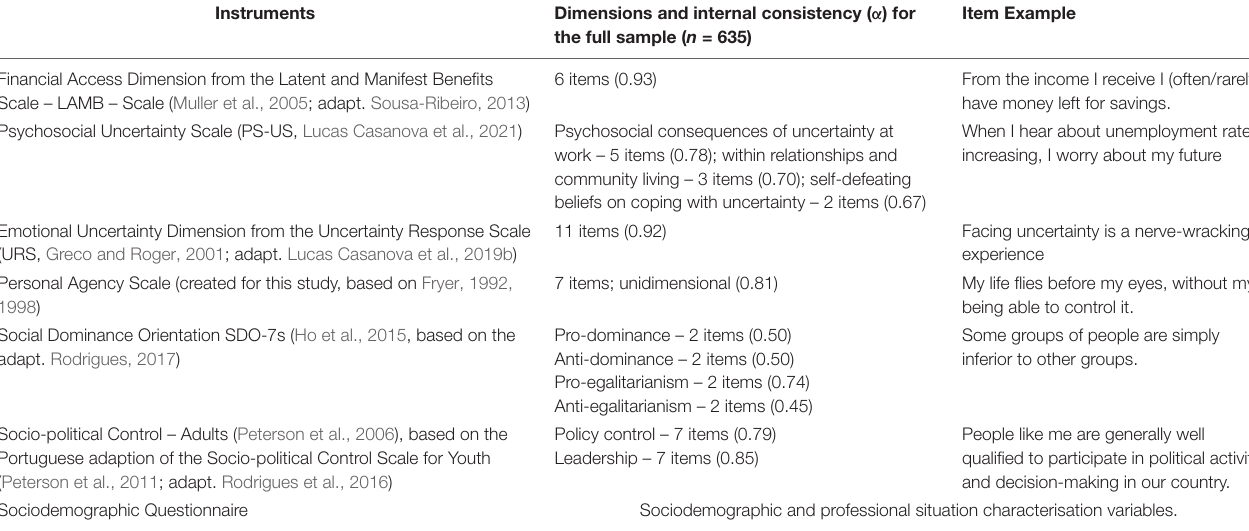
TABLE 2 | Instruments. Instruments Item